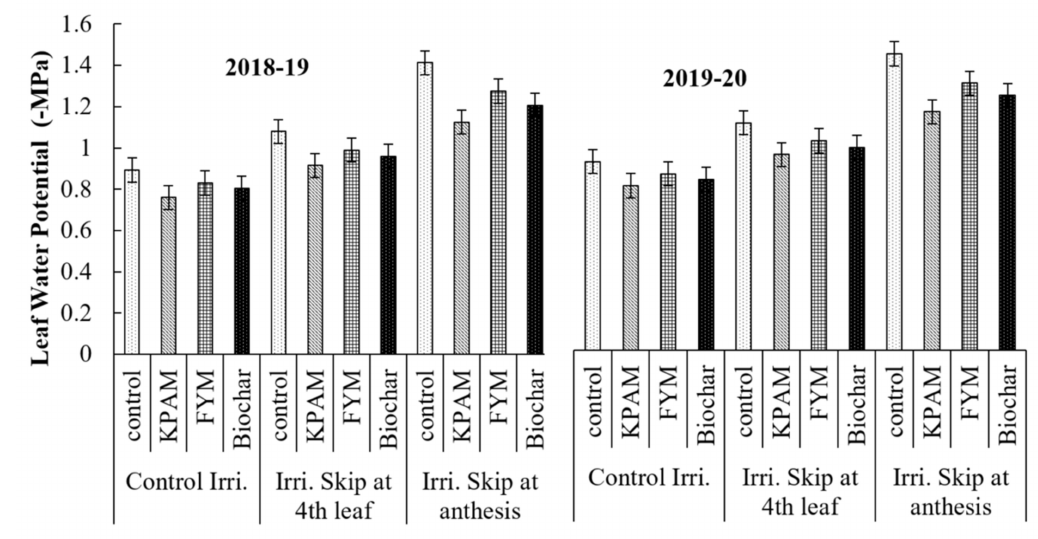
Figure 3. Effect of soil amendment materials on water potential in the wheat crops grown under normal and water stress imposed by skipping irrigation at 4th leaf and anthesis stage of growth (mean values ±